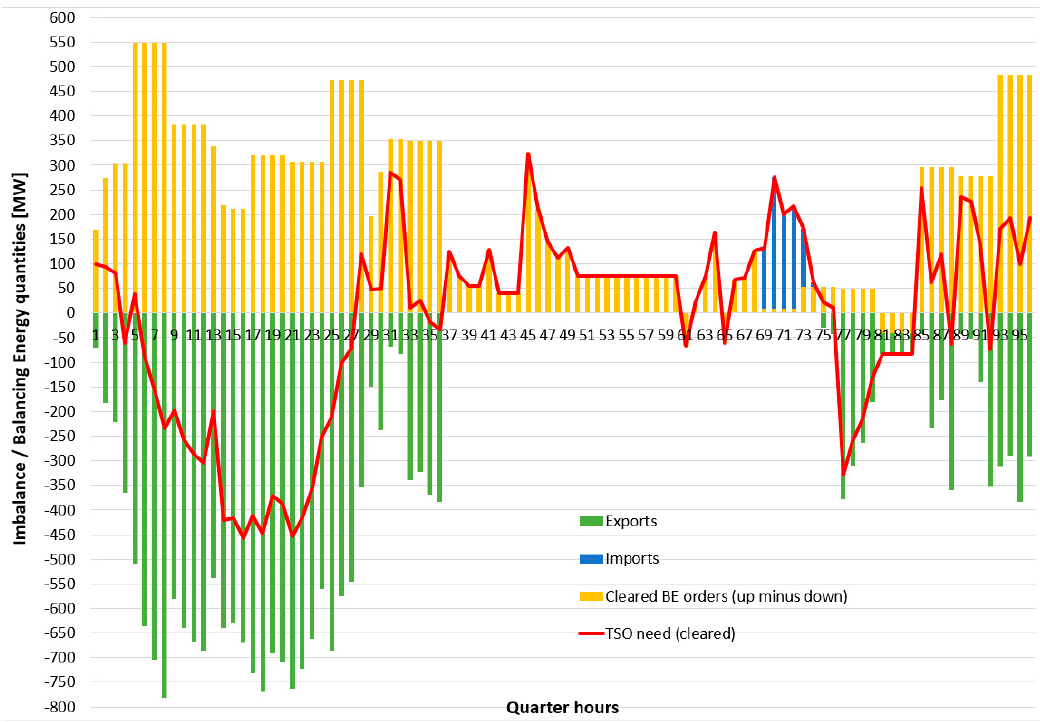
Figure 15. Clearing results per RTU for Greece.